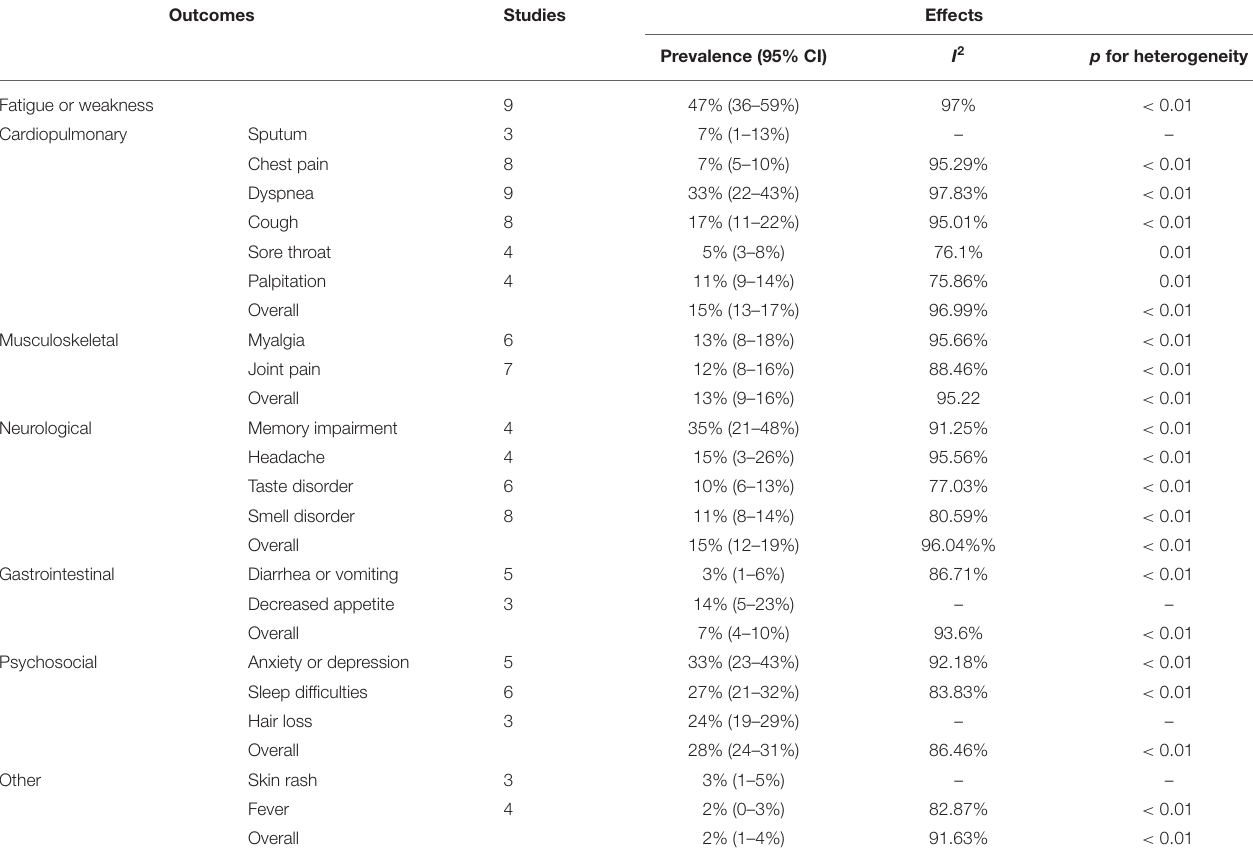
TABLE 2 | The prevalence of symptoms and manifestations in multiple